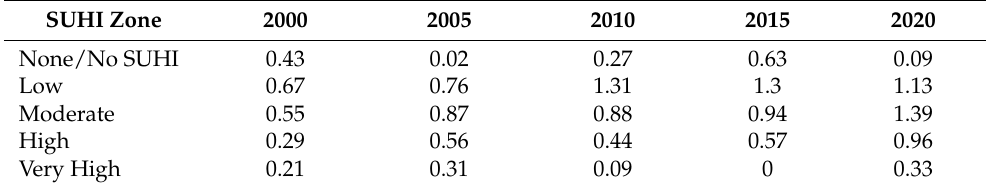
Table 6. Spatiotemporal variations in the area covered by different SUHII zones